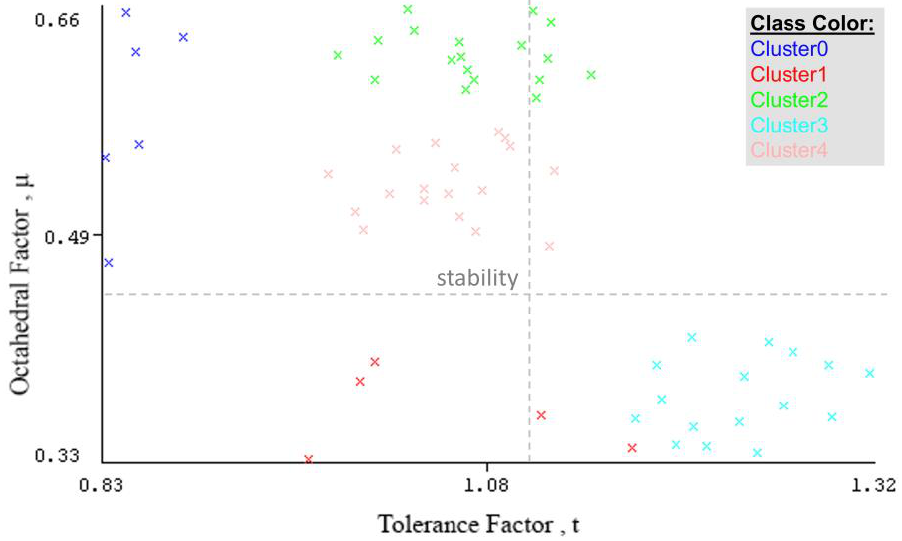
Figure 8. Values of tolerance and octahedral factors based on cluster number.